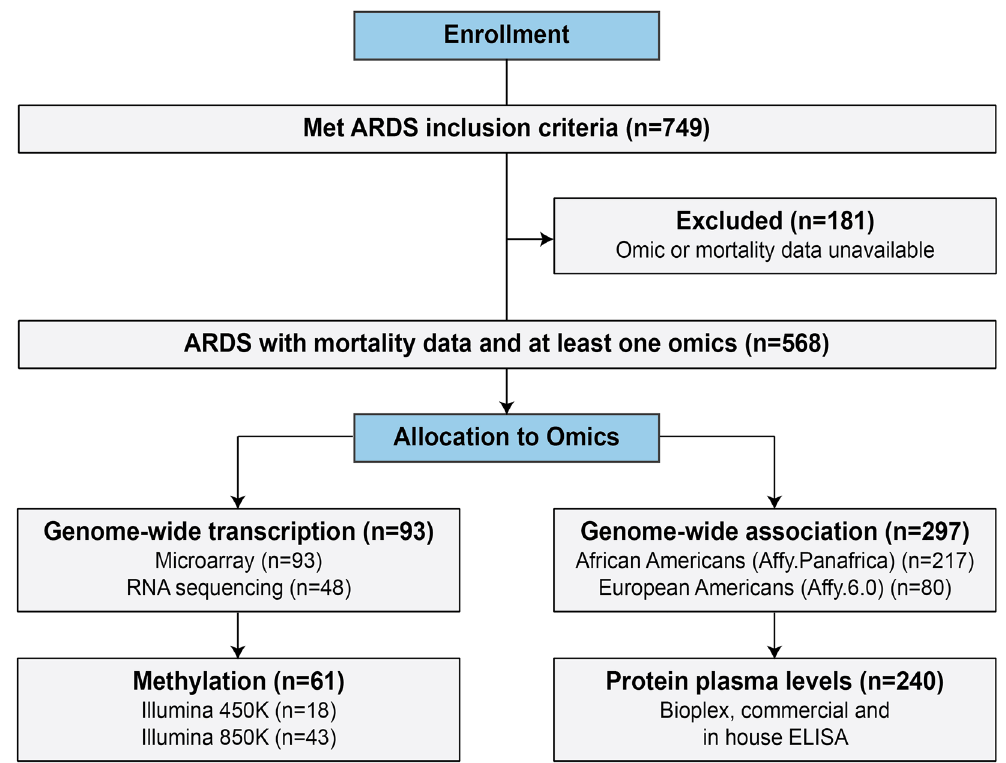
Figure 1. Flowchart of total study enrollment and subjects included in each of the “omics” platforms.